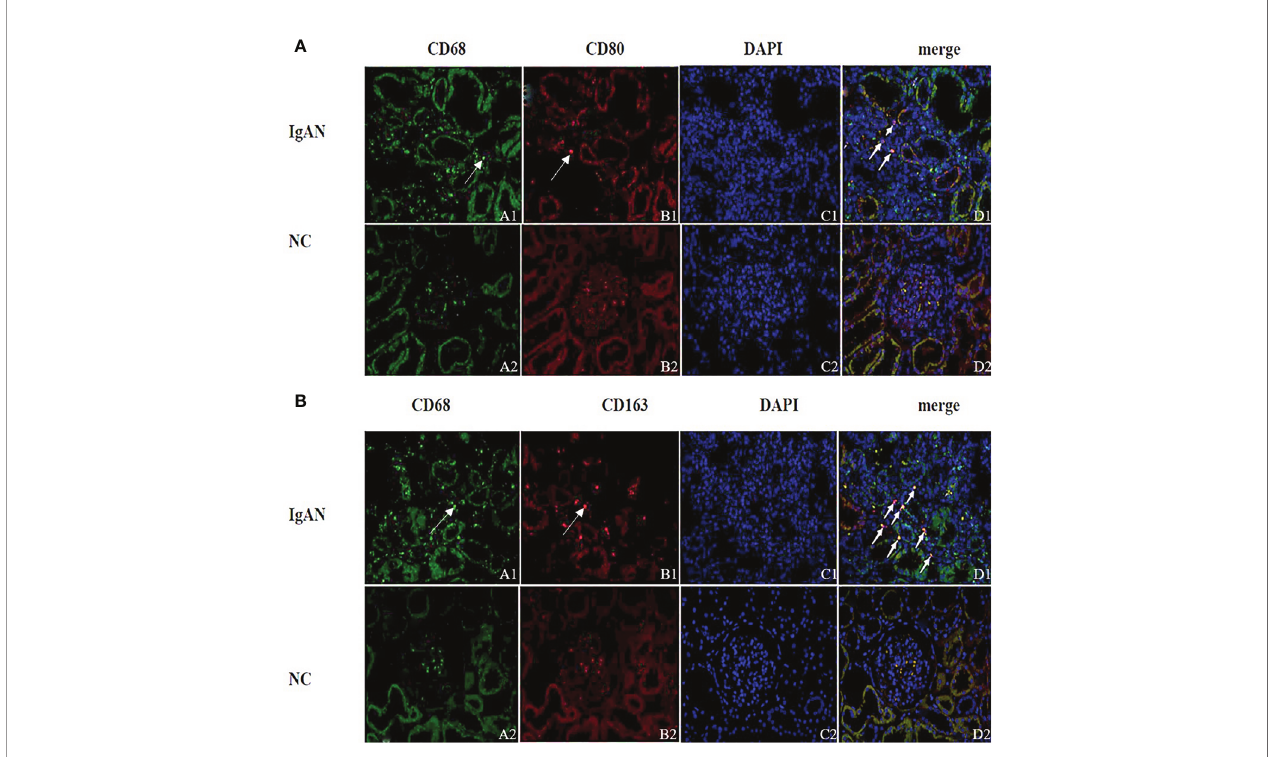
FIGURE 1 | Distribution of different macrophages in the renal interstitium. (A) Immuno fl uorescence double staining of CD68 and CD80 (A1 showed CD68 + cells (green), B1 showed CD80+ cells (red), D1 showed CD68 + CD80 + cells (yellow), and M0 polarized towards M1). (B) Immuno fl uorescence double staining of CD68 and CD163 (A1 shows CD68 + cells (green), B1 shows CD163 + cells (red), D1 shows CD68 + CD163 + cells (yellow), M0 polarization towards M2). (Original magni fi cation×400) PS: (A, B) A small amount of red blood cells was nonspeci fi c stained in the glomeruli of the NC group (None nucleus after merge, DAPI - ); Cell nuclei were stained blue with